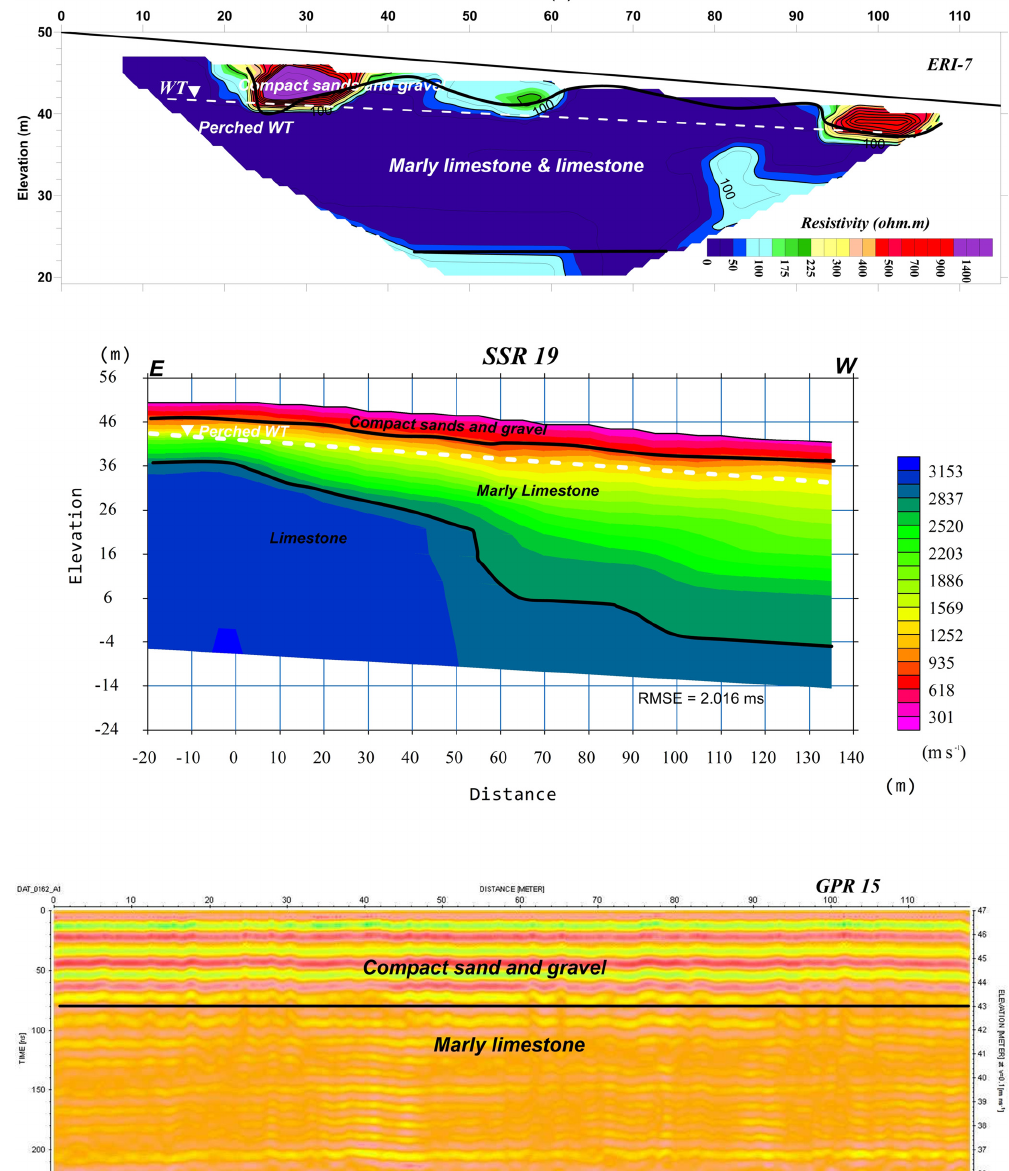
Figure 10. ERI, SSR, and GPR profiles in the causeway to Menkaure